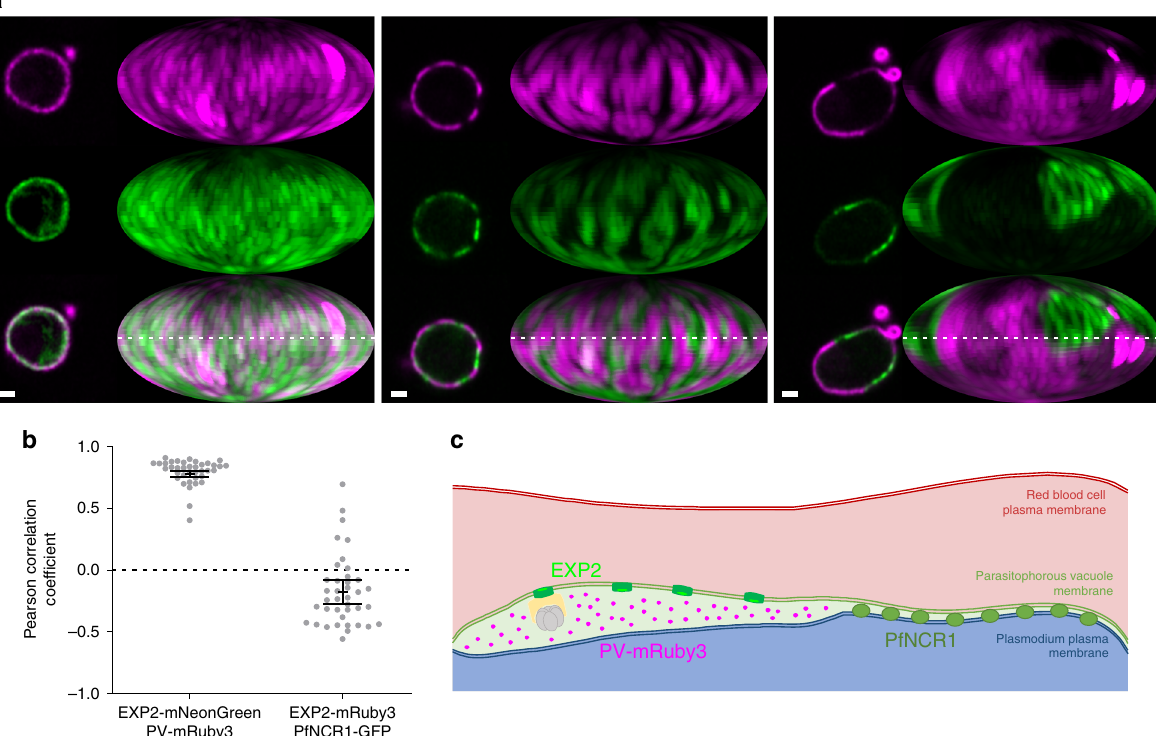
Fig. 4 Anti-colocalization of EXP2 and PfNCR1. a Center confocal slice and Mollweide projections of PfNCR1-GFP — EXP2-mRuby3 parasites. EXP2- mRuby3 (top, magenta), PfNCR1-GFP (middle, green), merge (bottom). Samples chosen represent examples of relatively low (0.48), average ( − 0.09) and high ( − 0.55) anti-correlation according to the Pearson correlation coef fi cients of the maps. The dotted line labels the equator, corresponds to the confocal slice. Scale bar: 1 µ m. b Pearson correlation coef fi cients of EXP2-mNeonGreen — PV-mRuby3 parasites ( N = 38 cells, see Fig. 3) in comparison to PfNCR1- GFP — EXP2-mRuby3 ( N = 39 cells). Regions that extend from the parasite to form the tubulovesicular network were excluded for the correlation analysis. Bars: mean ± 95% CI. Both distributions are signi fi cantly different: P = 1.2 × 10 − 29 ( t -test, two tailed). c Localization of EXP2 correlates with the existence of a relatively large PV lumen. The PV lumen can store proteins for export and accessory proteins to facilitate protein export. The lipid transporter PfNCR1 localizes to regions of close PPM-PVM apposition. Functionally, PfNCR1 may be able to directly contact the PVM to exchange lipids and sites of membrane apposition may be sites for the general exchange of lipophilic material, a functional hallmark of membrane contact sites. Source data are provided as a Source data fi